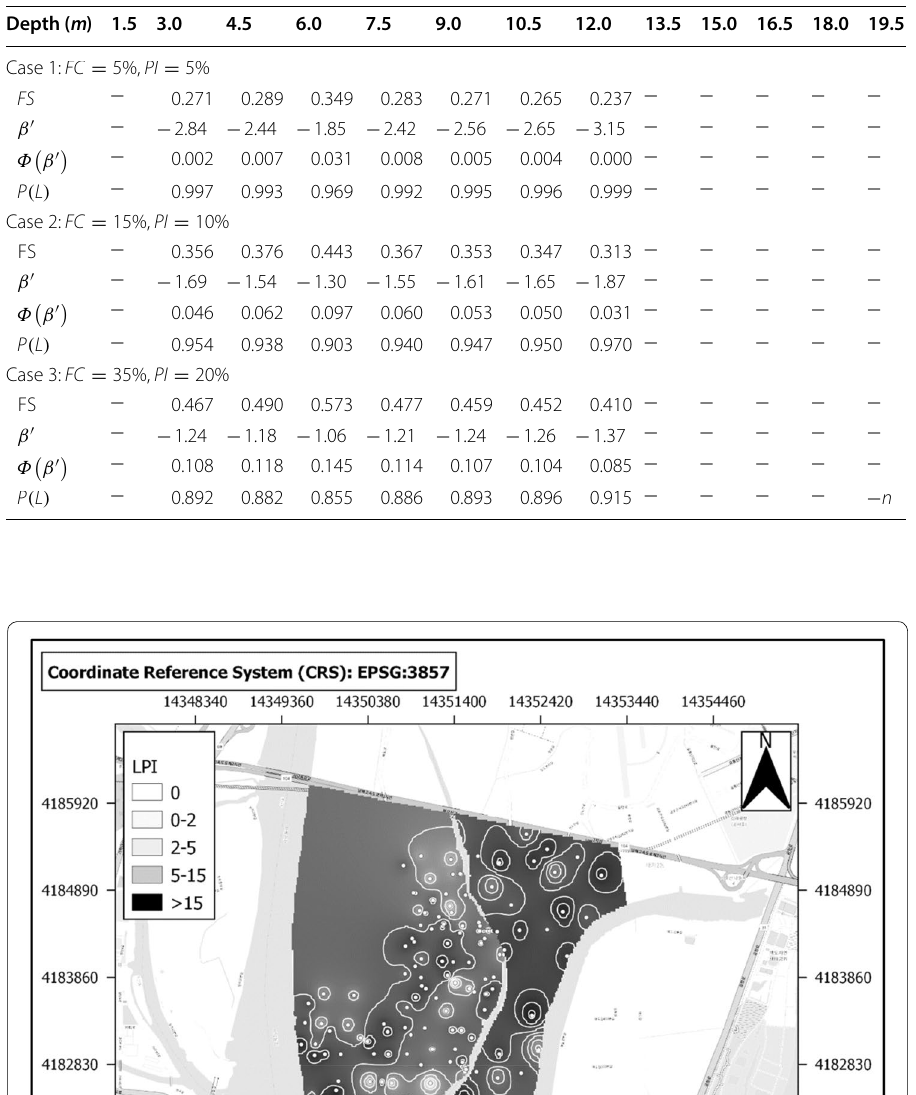
Table 8 Calculation details of liquefaction probability through Jha and Suzuki [15] method for borehole B-25